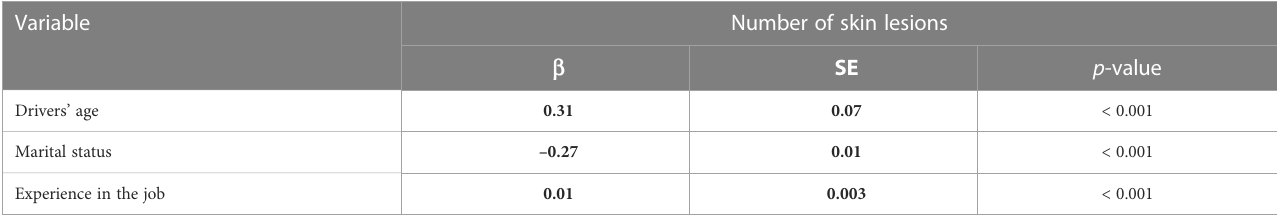
TABLE 4 Results from a multilevel mixed-effects linear regression model of the relationship between the number of skin lesions and sociodemographic characteristics in fattening pigs in a Colombian slaughterhouse. Variable